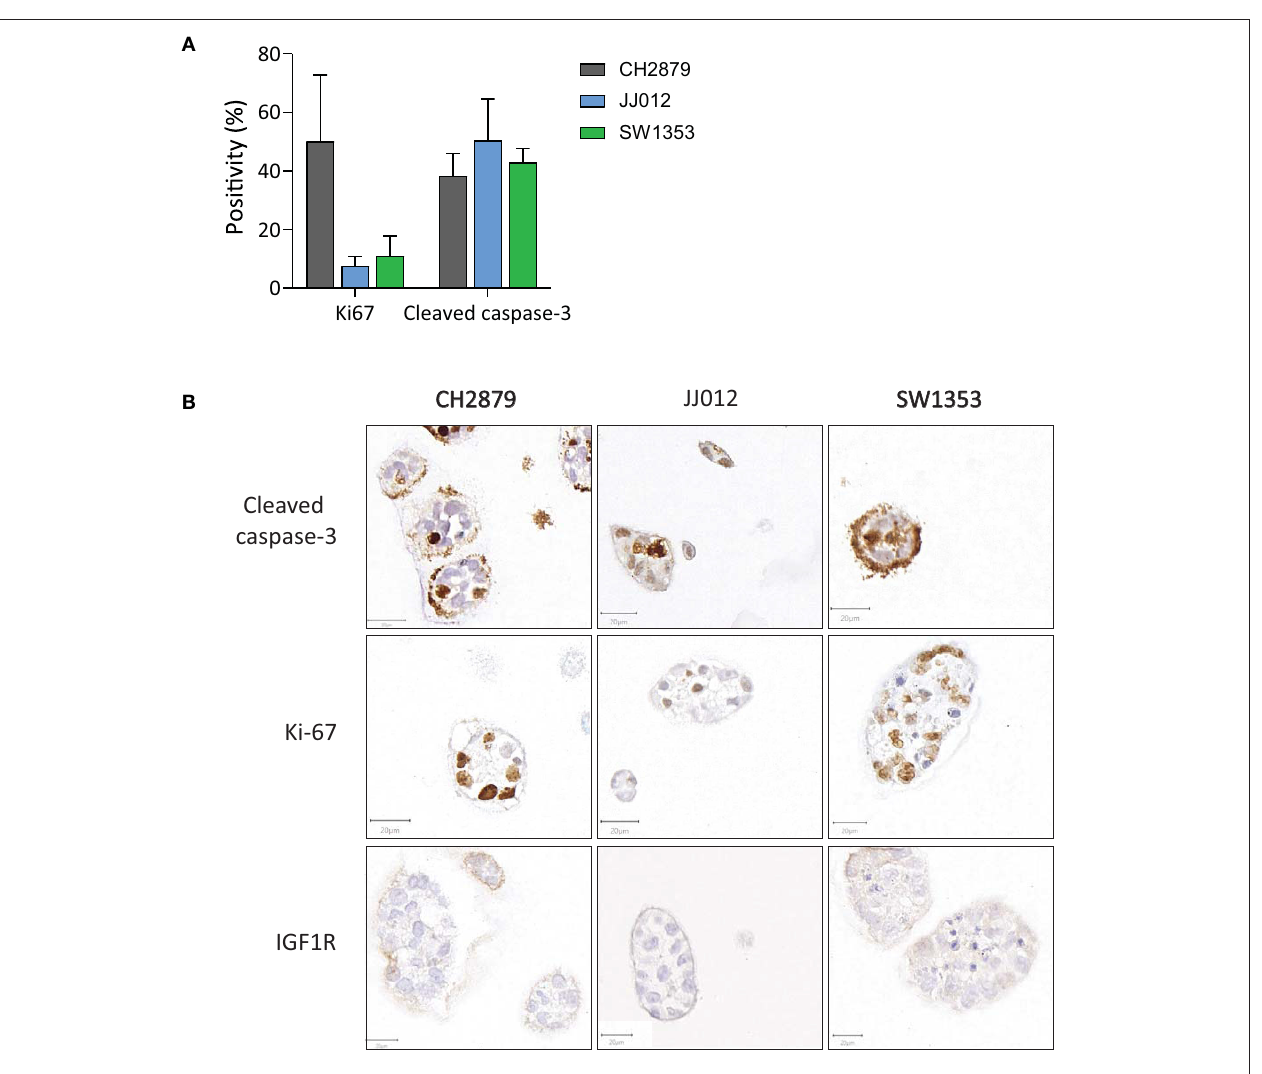
FIGURE 2 | (A) Quantification of apoptosis (cleaved caspase 3) and proliferation (Ki-67) in the spheroids showed that on average < 50% of cells were apoptotic. Proliferation was observed in all cell lines, and was particularly high for CH2879. (B) Apoptosis (cleaved caspase 3), proliferation (Ki-67) and IGF1R expression patterns varied within spheroid cultures. IGF1R was not expressed ( n ≥ 3). Scale bar = 20 µ m.